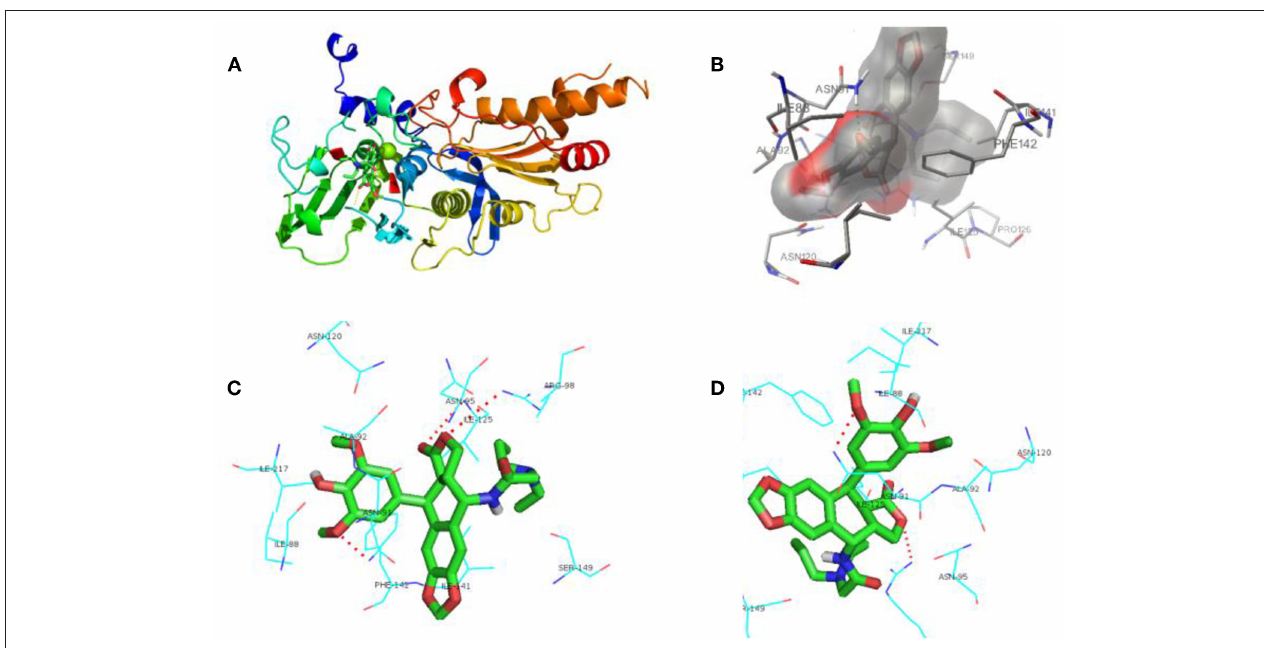
FIGURE 6 | Docking poses for compound 12g in the active site of human DNA topoisomerase II α . (A) X-ray crystal structure of human DNA topoisomerase II α active site in complex with 12g (green). (B) Inhibitor 12g was bound to the hydrophobic groove of DNA topoisomerase II α . (C,D) View of compound 12g (green) docked in the binding residues of human topoisomerase II α from different